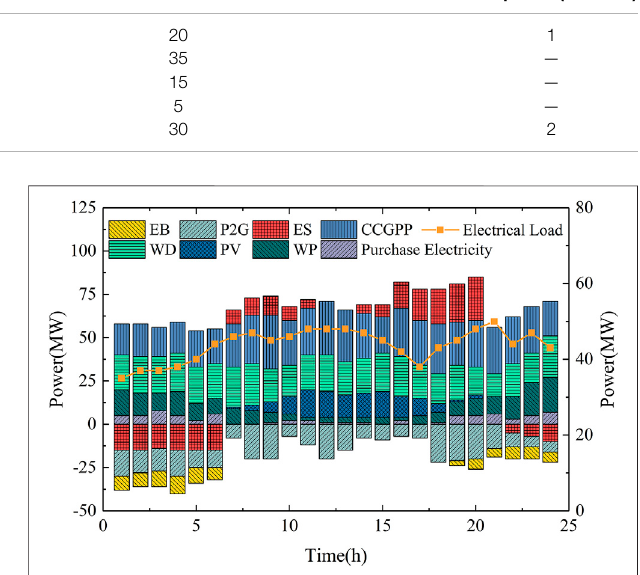
FIGURE 6 | Power balance curve of Scene 4.